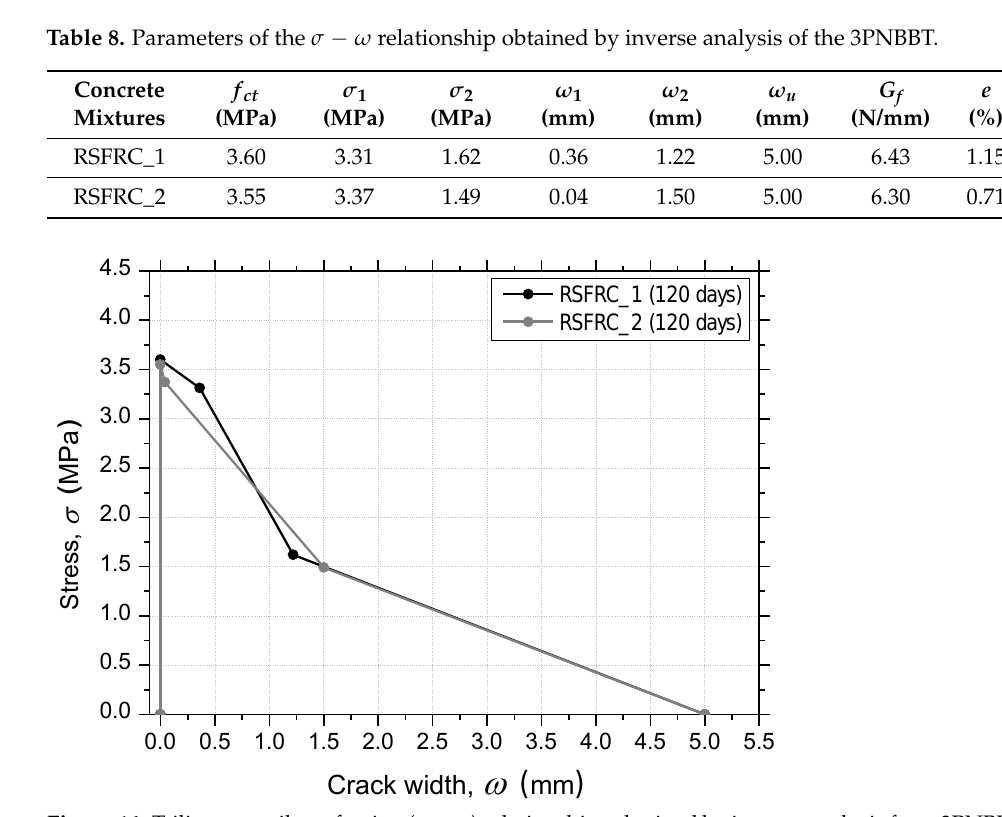
Figure 14. Trilinear tensile–softening ( σ − ω ) relationships obtained by inverse analysis from 3PNBBT.